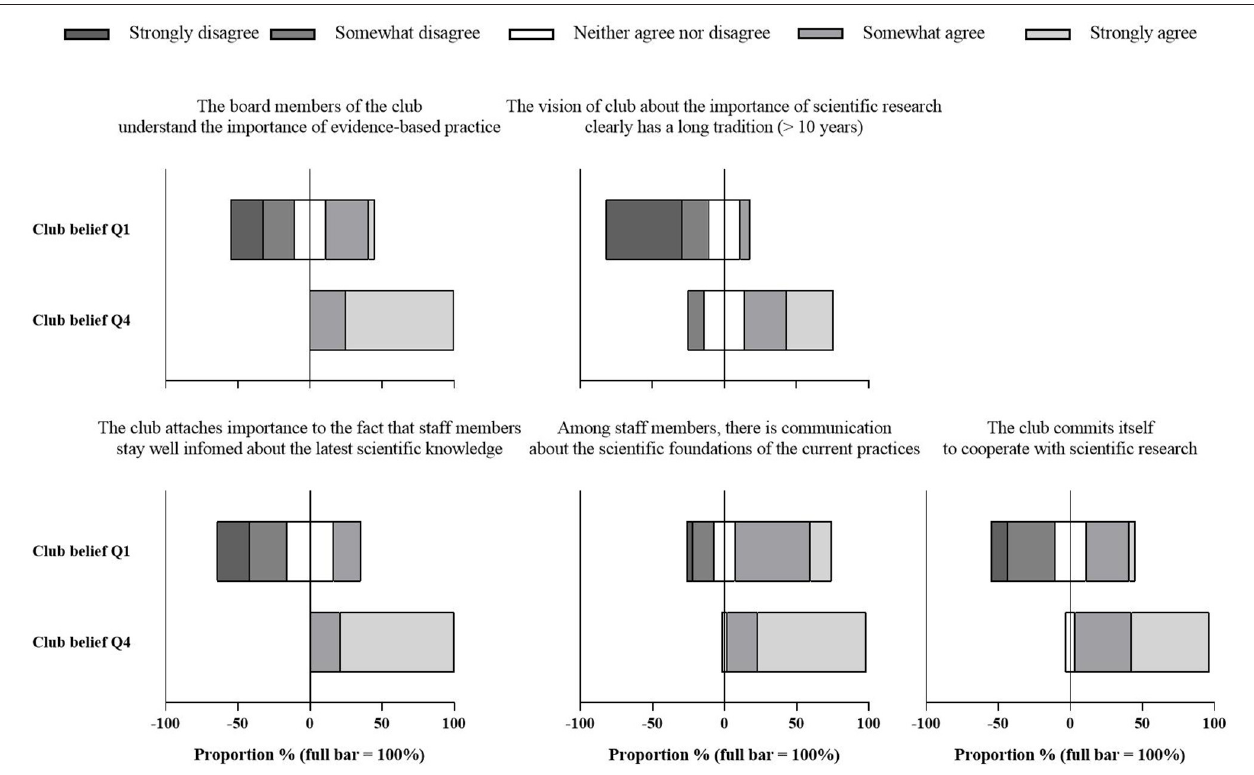
FIGURE 1 | Responses to the five Likert scale questions examining the club belief on the benefit of EBP. Results are presented as the proportion of clubs in quartile 1 (Q1) and quartile 4